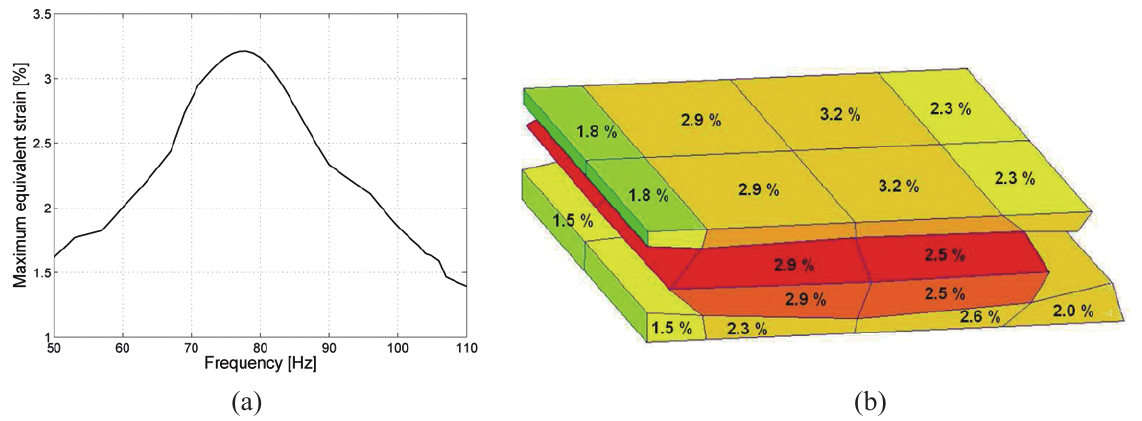
Fig. 6. Equivalent Deformation: (a) Equivalent strain for element id 50099 (b) Deformed rubber mount and equivalent strain distribution at 83 Hz ( fi gures correspond to equivalent strains and colours to strain energy